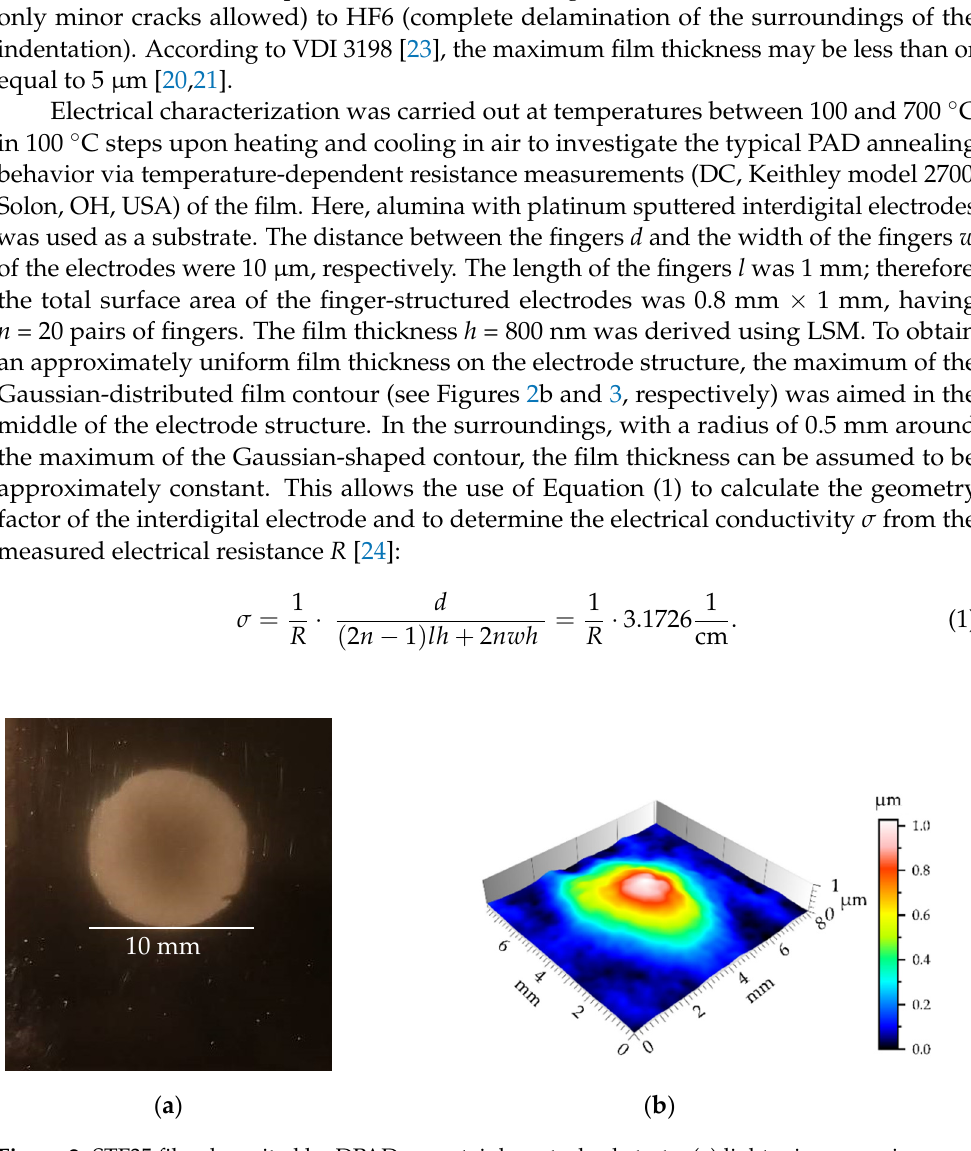
Figure 2. STF35 film deposited by DPAD on a stainless steel substrate: ( a ) light microscope image of the as-deposited film; ( b ) three-dimensional film profile as measured by LSM (with color-indicated film thickness).